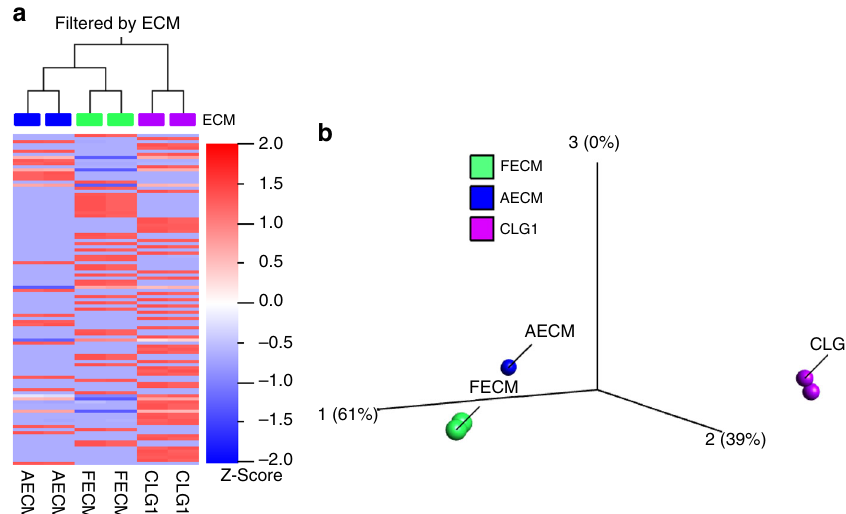
Fig. 4 RNA-sequencing data for glioblastoma 3D bioengineered cultures. a Heatmap along with clustering based on extracellular matrix generated using FPKM (Reads Per Kilobase of transcript per Million mapped reads) values. b Principal component analysis (PCA) plot. FECM- Fetal ECM + collagen I, AECM- Adult ECM + Collagen I, CLG1-Collagen I. False discovery rate (q) = 0.04, p- value = 0.00008; n = 2 per condition Source data are provided